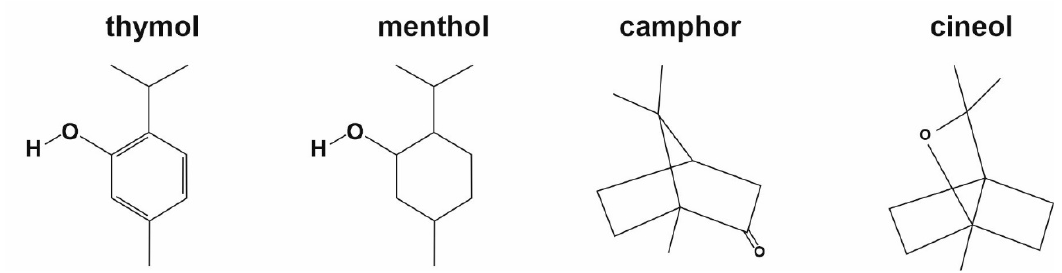
Figure 1. Structural formulas of the terpenoids thymol, menthol, camphor and cineol used for encapsulation into invasomes.